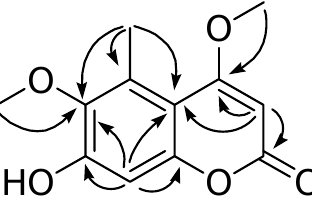
Figure 2. Key HMBC (H → C) correlations of 1